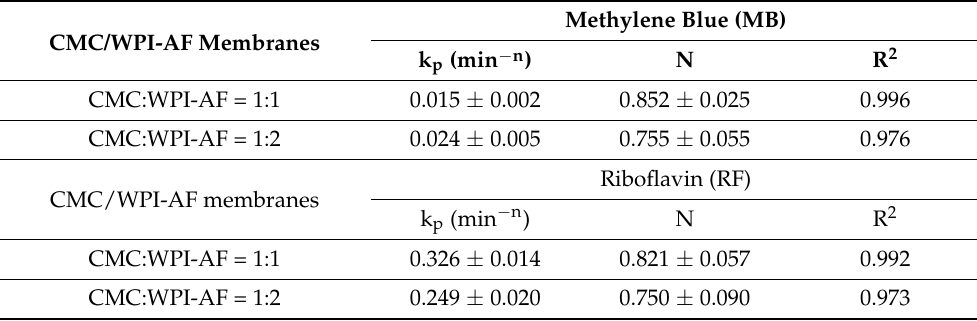
Table 3. Estimates of the Korsmeyer-Peppas model parameters for MB or RF release from CMC/WPI- AF membranes synthesized at CMC:WPI-AF mass ratios of 1:1 and